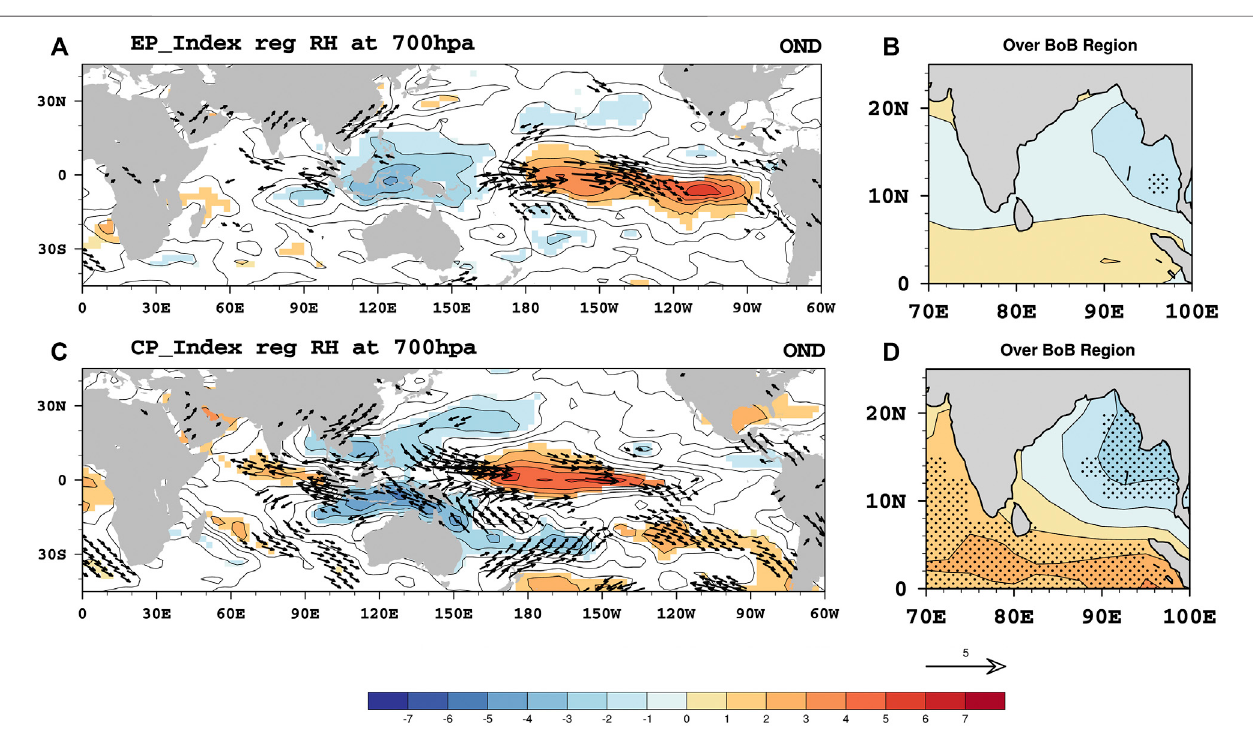
Frontiers in Earth Science |